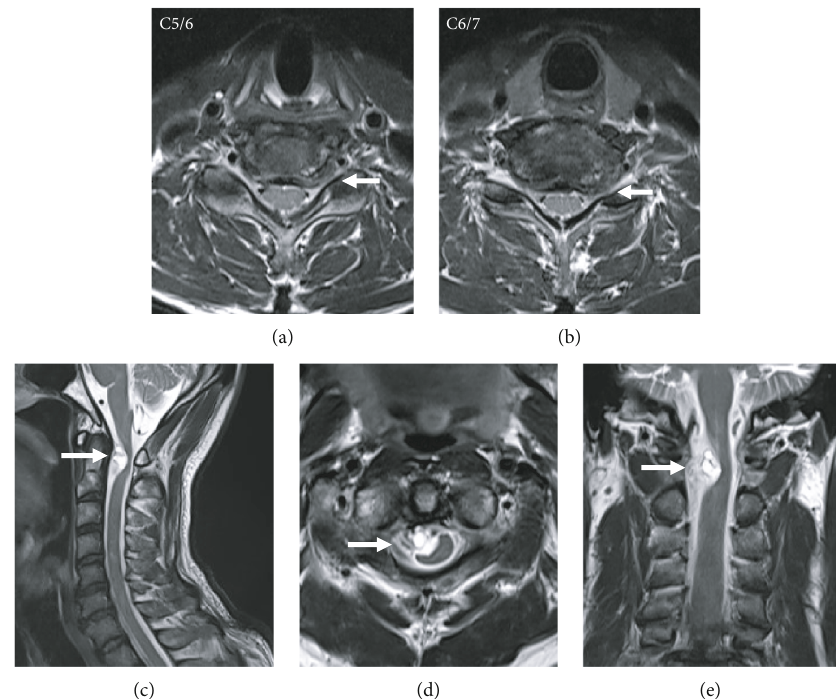
Figure 2: Noncontrast-enhanced magnetic resonance images. In horizontal sections (a, b), cervical disc herniation happened in the same region as the left C5-6 and C6-7 stenoses (arrow). At the C1-2 level, an intradural extramedullary cystic lesion existed in the right side of ventral cervical spinal cord, which severely compressed the spinal cord ((c) sagittal, (d) horizontal, and (e) coronal, arrow).